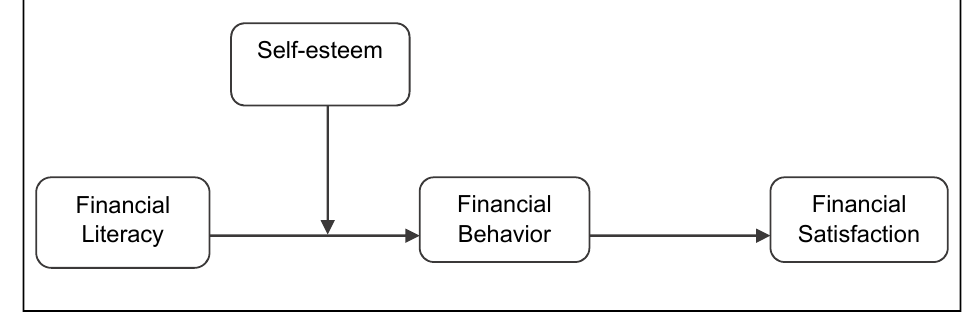
Figure 1: Research Model/ Conceptual framework of the